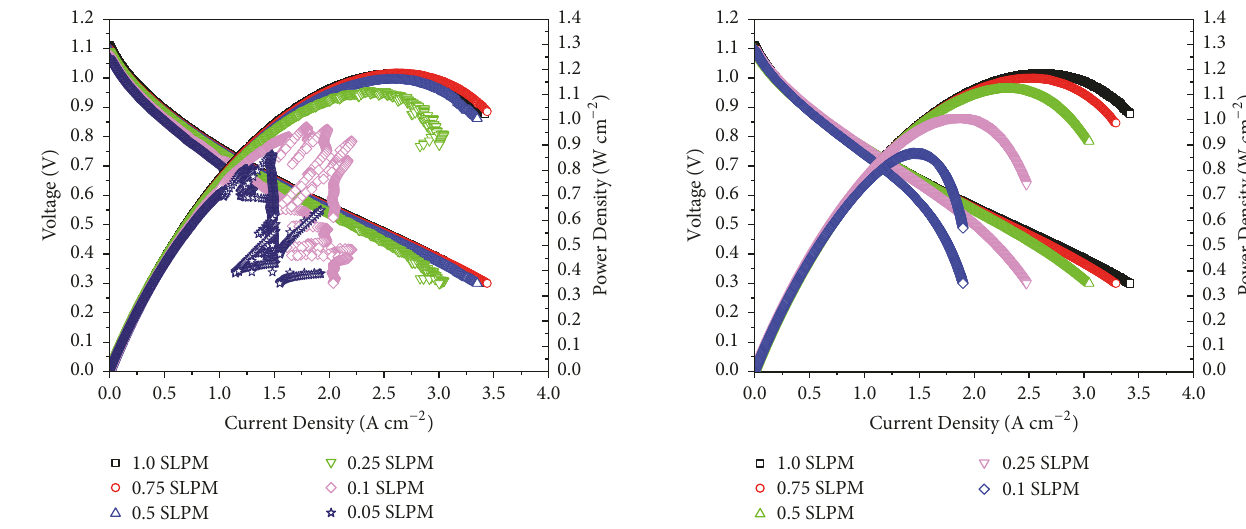
Figure 9: Voltage and power density curves versus current density at different hydrogen flow rates at 750 ∘ C.